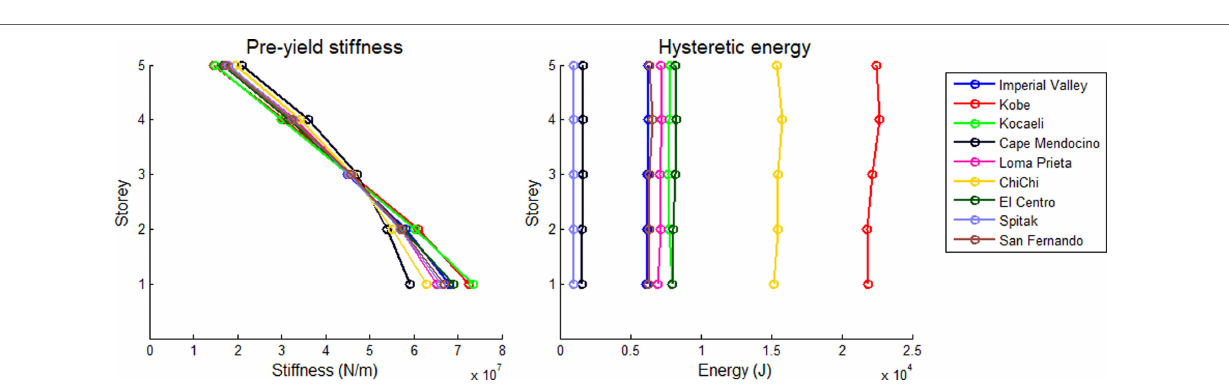
FIGURE 8 | Optimum distributions of elastic pre-yield stiffness and energy dissipated due to hysteresis for the 5-storey shear building with ξ = 5%, (cid:22) uy = 0.1 for various earthquake